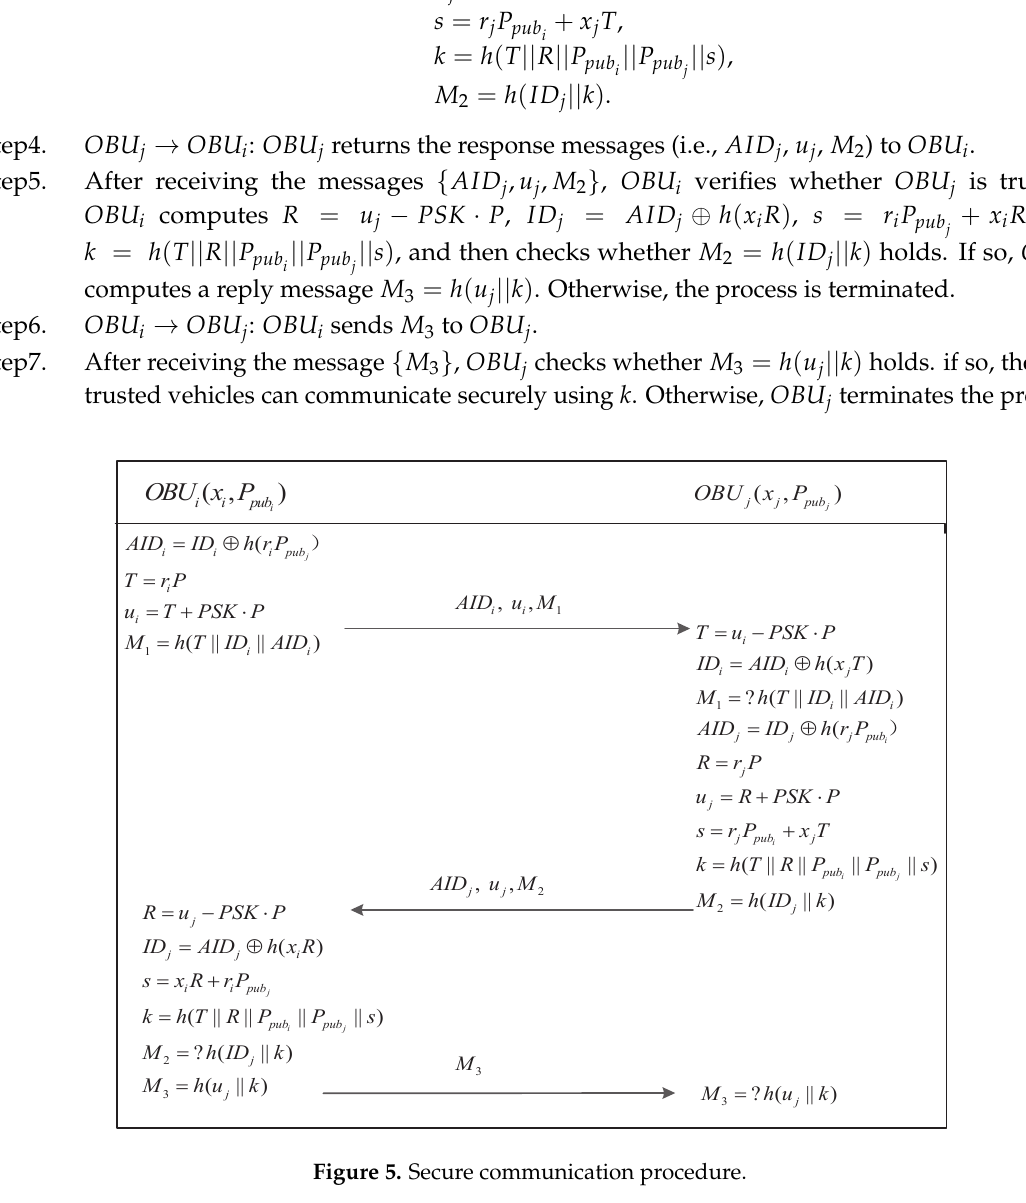
Figure 5. Secure communication